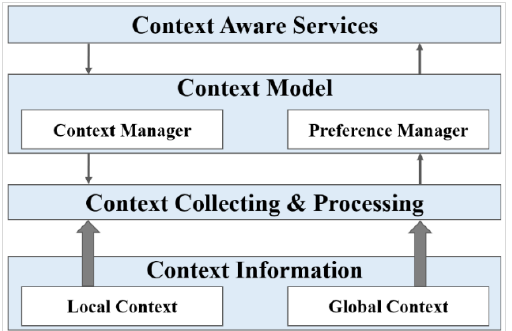
Figure 9. General context-aware architecture enables the system to optimize services by utilizing the available context